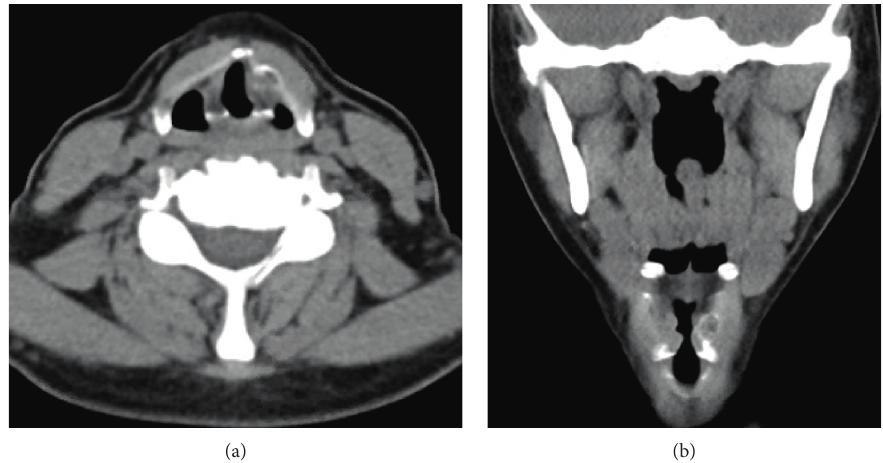
Figure 2: Axial (a) and coronal (b) CT without contrast demonstrating a mass arising from the left thyroid cartilage lamina with a thin calcified rim and a heterogeneous decreased attenuation